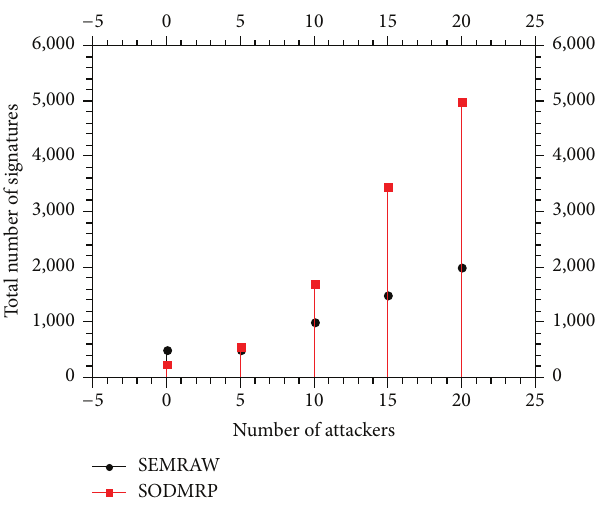
Figure 4: Signature overhead for varying number of attacker